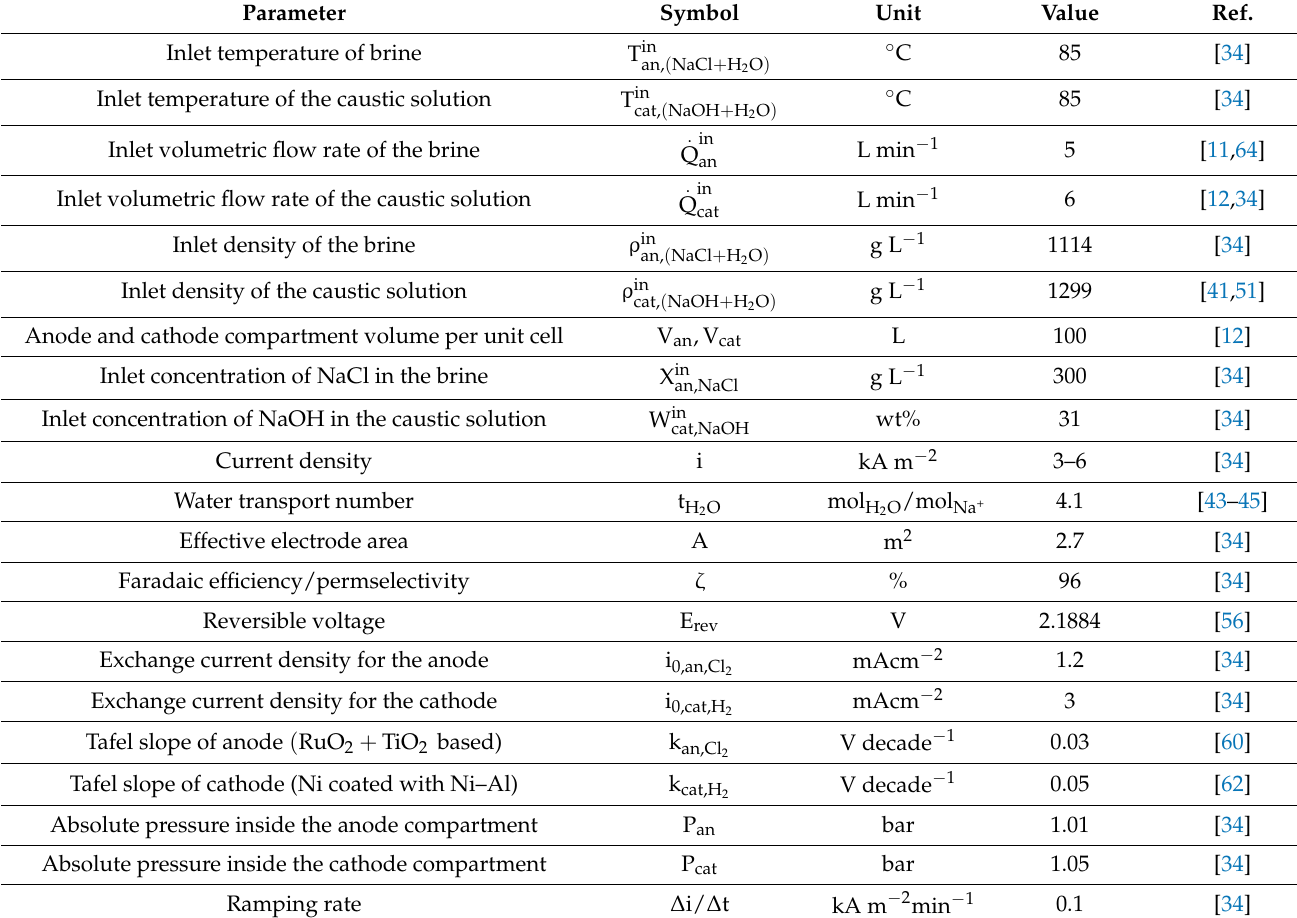
Table 3. Values of input parameters used in the model for the simulation of the single chlor-alkali cell. Parameter Symbol Unit Value Ref. ◦ C T in an, ( NaCl + H 2 O )